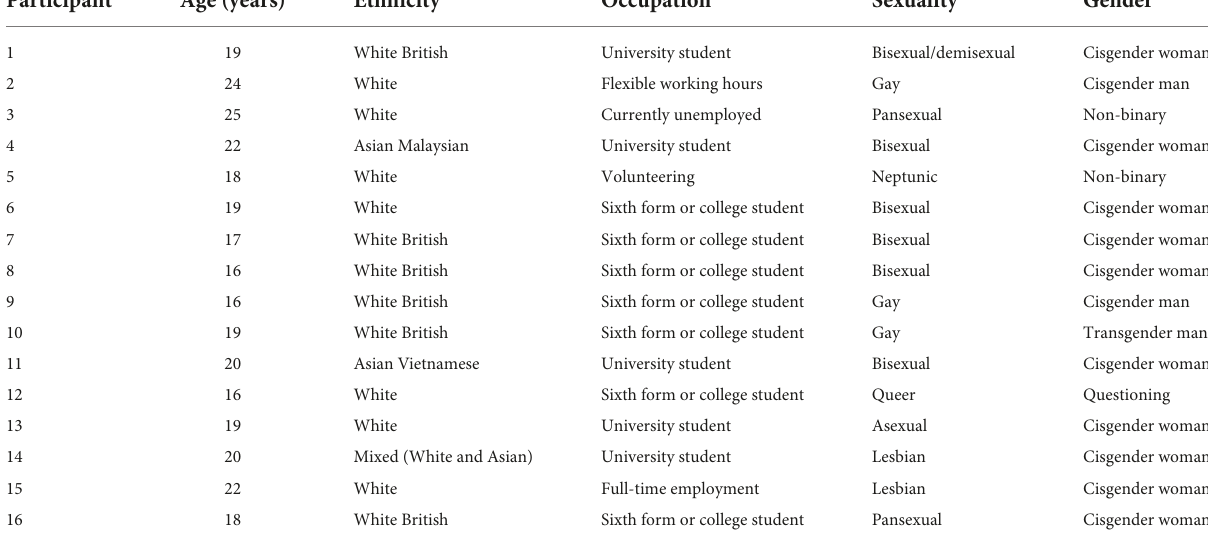
TABLE 2 Full participant sample